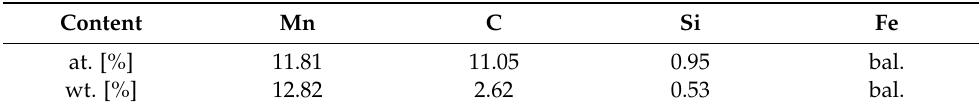
Table 2. The quantitative results of the surface microanalysis of the chemical composition shown in Figure 8. Content